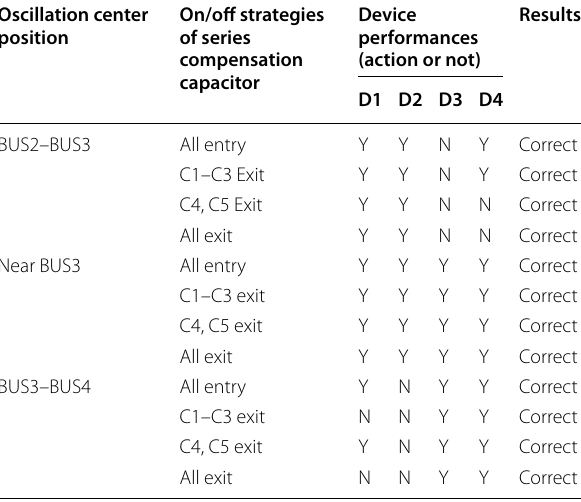
Table 5 Performance of the devices in test scenario 1 Oscillation center position